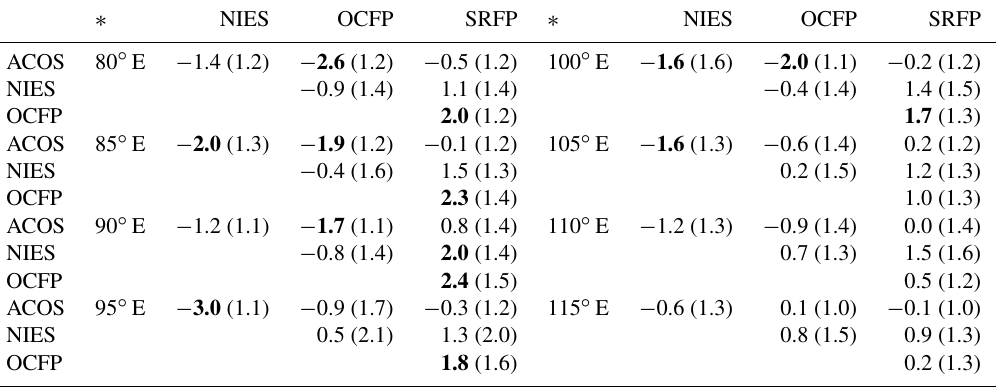
Table 4. Differences (ppm) between the two algorithms (column algorithm minus row algorithm) and the corresponding SD (ppm) for each cell, where values in parentheses are the corresponding SDs. The differences larger than 1.5ppm are highlighted in bold. ∗ NIES OCFP SRFP ∗